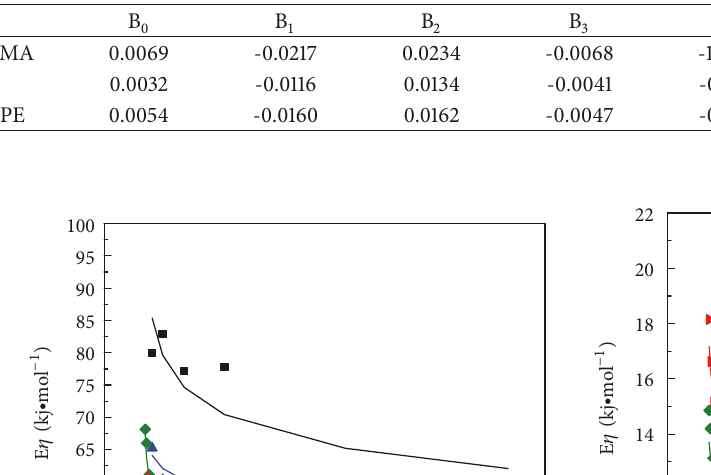
Table 4: Material parameters in the size-based Non-Newtonian index model (SNNE) model.